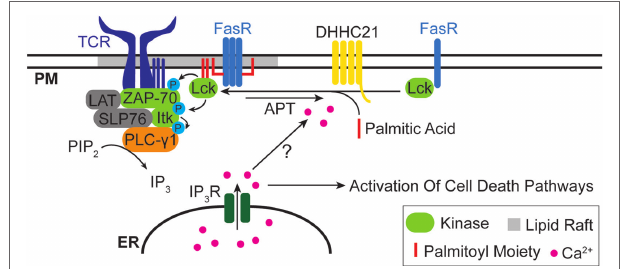
FiGURe 1 | Lipidation and Fas death receptor signaling. The Src kinase Lck is rapidly palmitoylated upon Fas stimulation and partitioned into lipid rafts, where it interacts with the T cell receptor (TCR) complex and leads to downstream apoptotic calcium release. The plasma membrane-localized palmitoyl acyltransferases DHHC21 is essential for Lck palmitoylation. The identity of the depalmitoylating enzyme(s) for Lck is